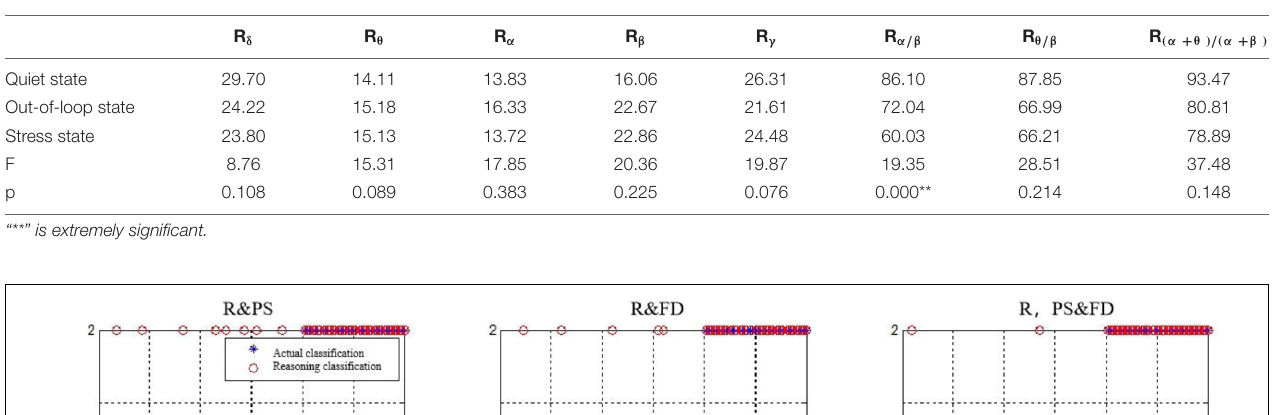
TABLE 8 | Results of EEG parameters (units in top 3 rows:%).